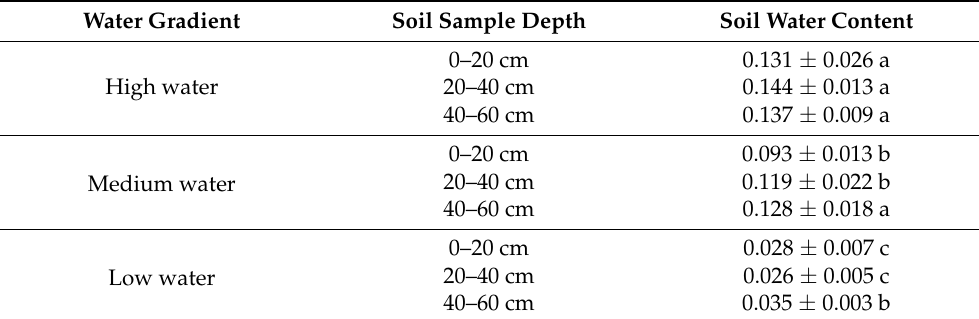
Table 1. Analysis of variance of soil water content and division of water gradients. Water Gradient